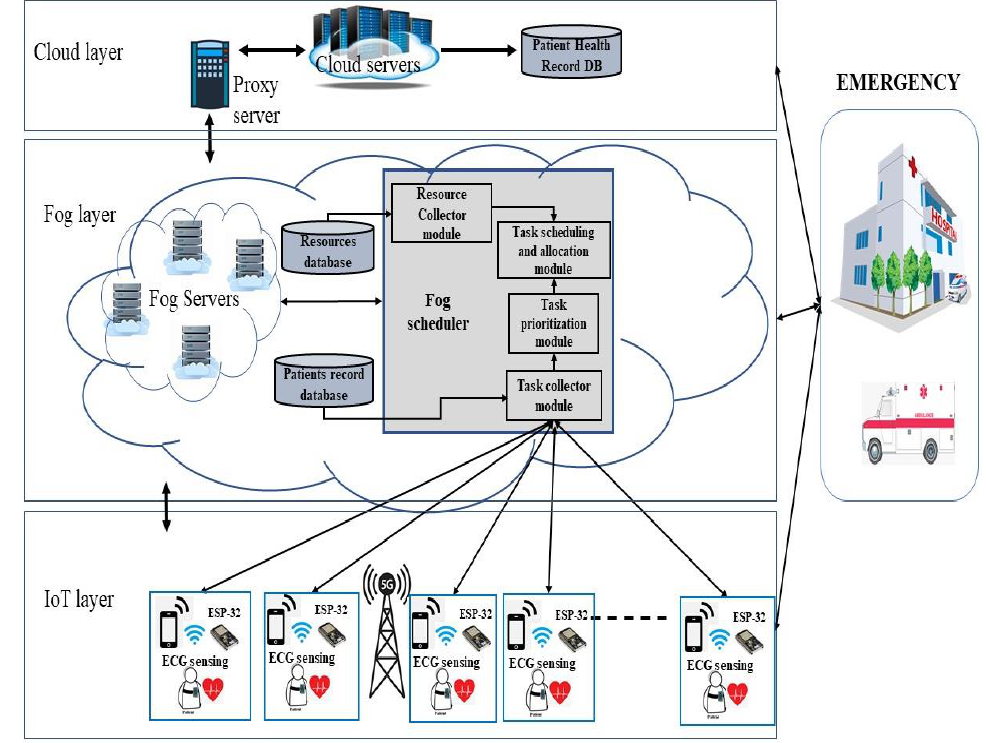
Figure 2. The proposed EEIoMT framework.